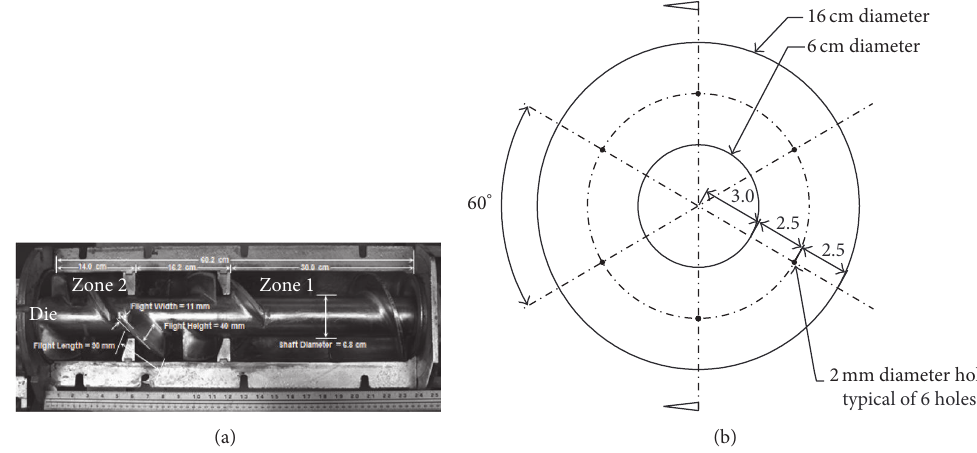
Figure 1: (a) Extruder barrel configuration; (b) die plate